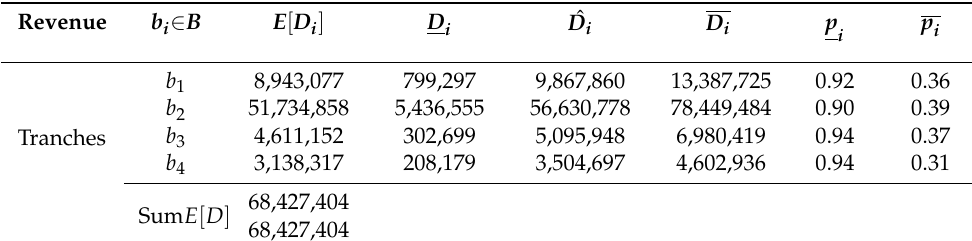
Table 4. Randomized data of